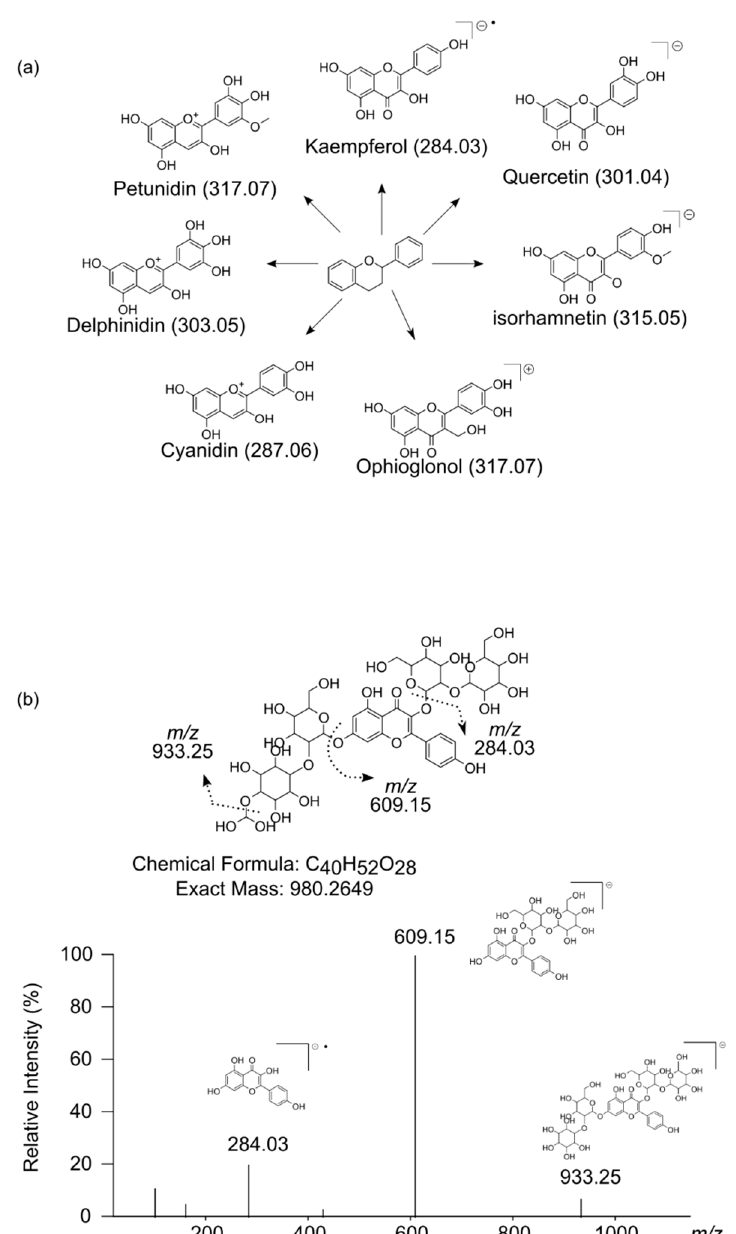
Figure 4. Identification of flavonoids based on MS/MS fragmentation patterns. ( a ) Ions corresponding to aglycones of the different flavonoids identified in this work. The central structure corresponds to the basic skeleton of flavonoids. The mass of each flavonoid aglycone is reported in brackets. ( b ) Proposed structure for the m / z 980.2649. Dot lines indicate the hypothetical pattern of fragmentation of the proposed molecule based on the experimental MS/MS mass spectrum obtained.